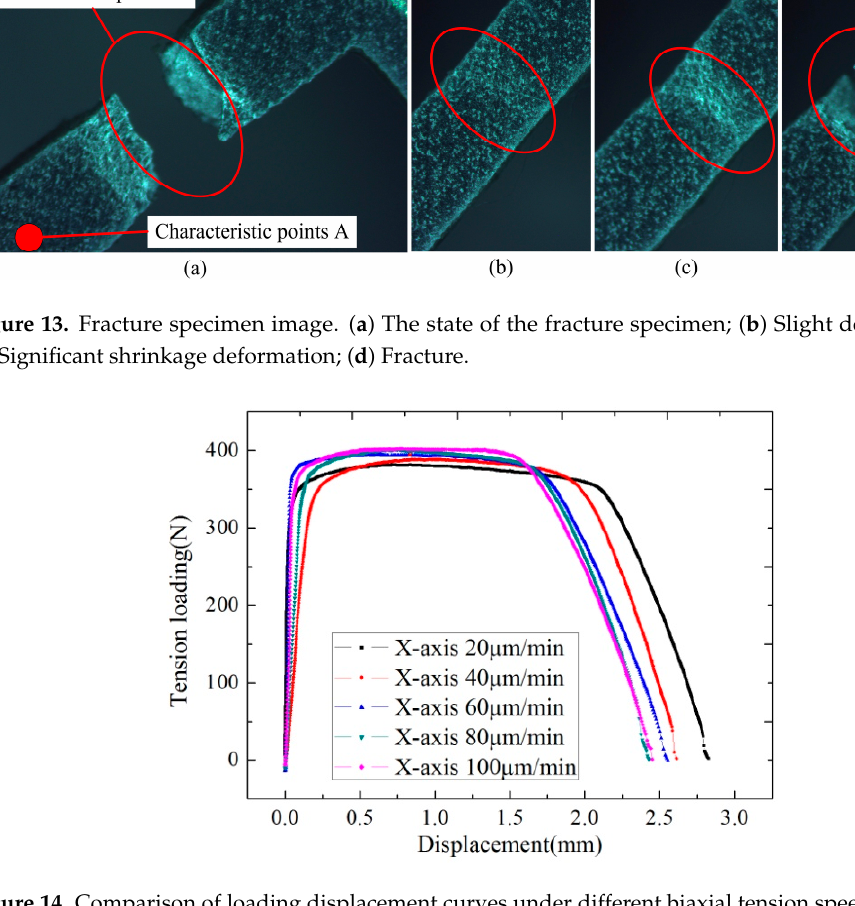
Figure 14. Comparison of loading displacement curves under different biaxial tension speeds (X-axis).